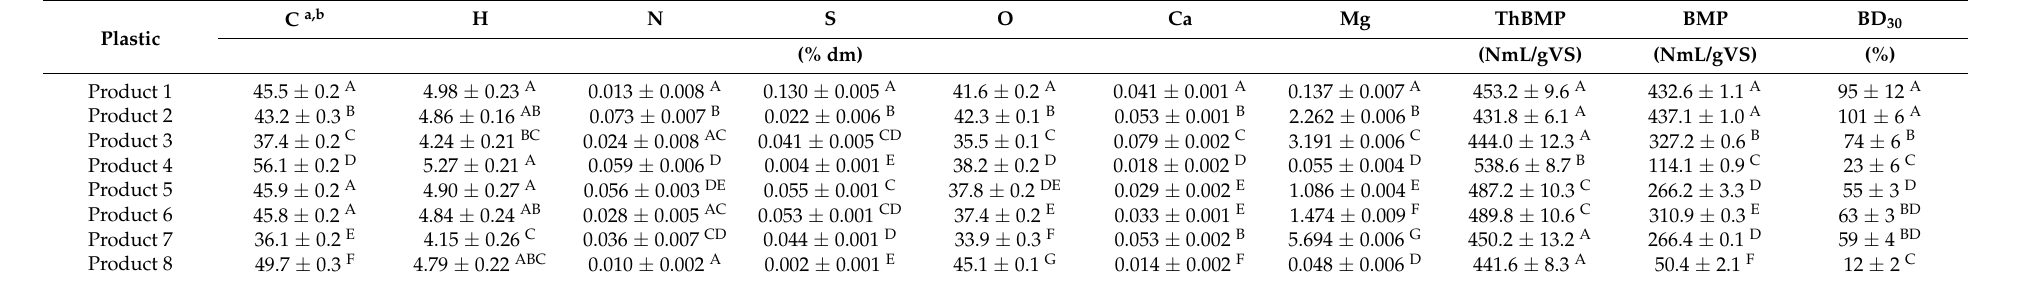
Table 4. Results of the elemental analysis. The percentages by dry mass of carbon, hydrogen, nitrogen, oxygen, and sulfur were used to calculate the theoretical biomethane potential of each plastic